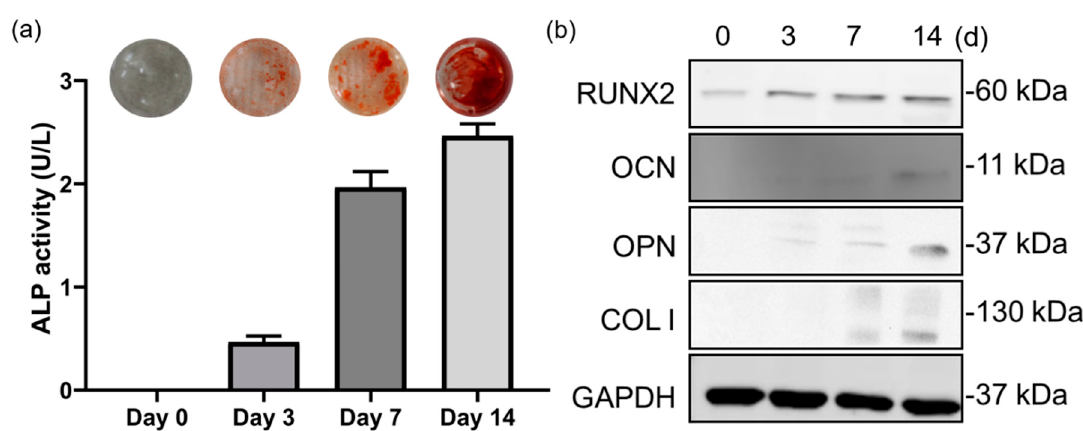
Figure 9. Evaluation of the osteogenic differentiation of the WJ-MSCs. ( a ) Alkaline phosphatase assay and Alizarin red stain, ( b ) western blot for osteogenic markers.